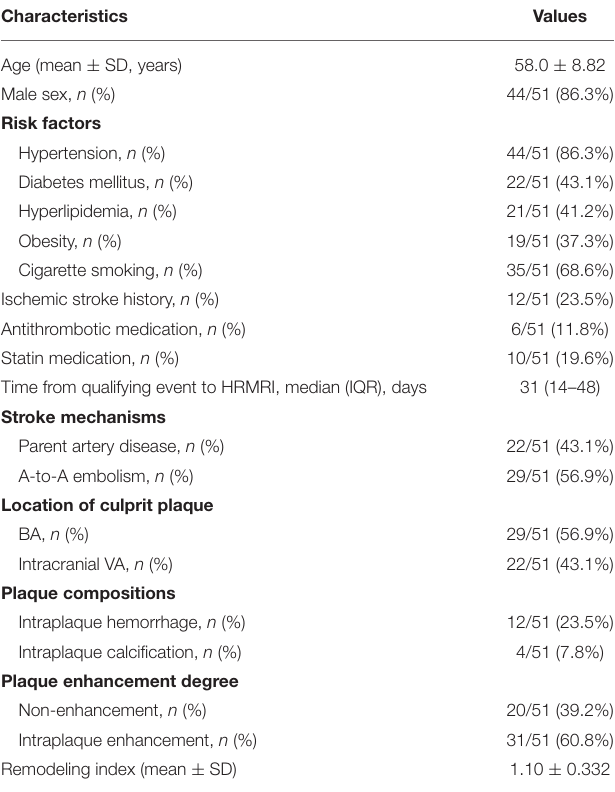
TABLE 2 | Patient baseline characteristics between the parent artery disease group and A-to-A embolism group. Clinical